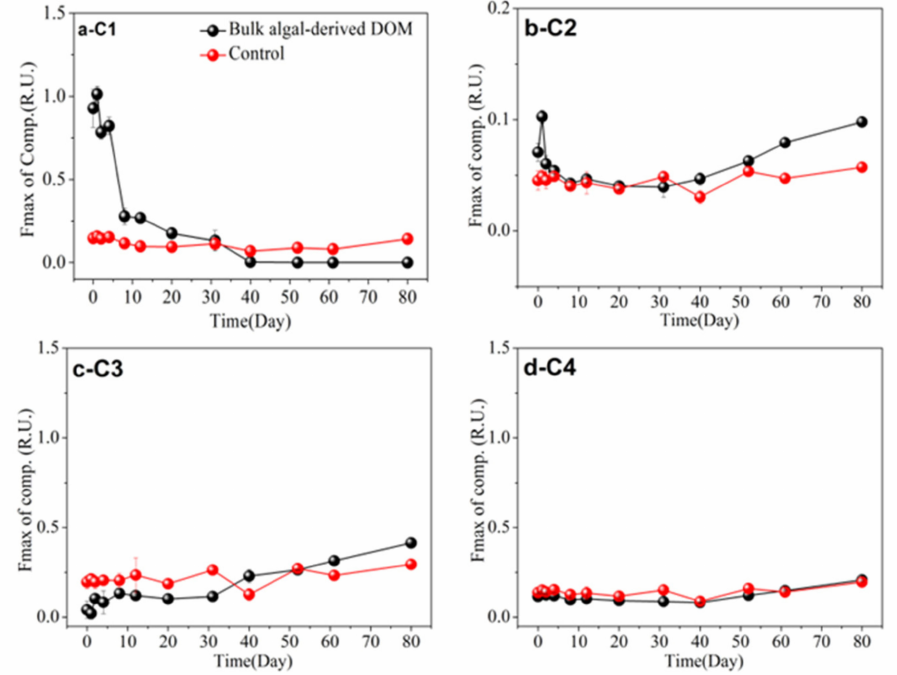
Figure 6. Dynamic changes in the main components of fluorescent dissolved organic matter (FDOM) during the 80-d degradation processes of the algal-derived DOM group and in the natural lake water group (as control). ( a ) C1, ( b ) C2, ( c ) C3, and ( d ) C4. Similarly, four FDOM components (C1, C2, C3, and C4) were identified in the